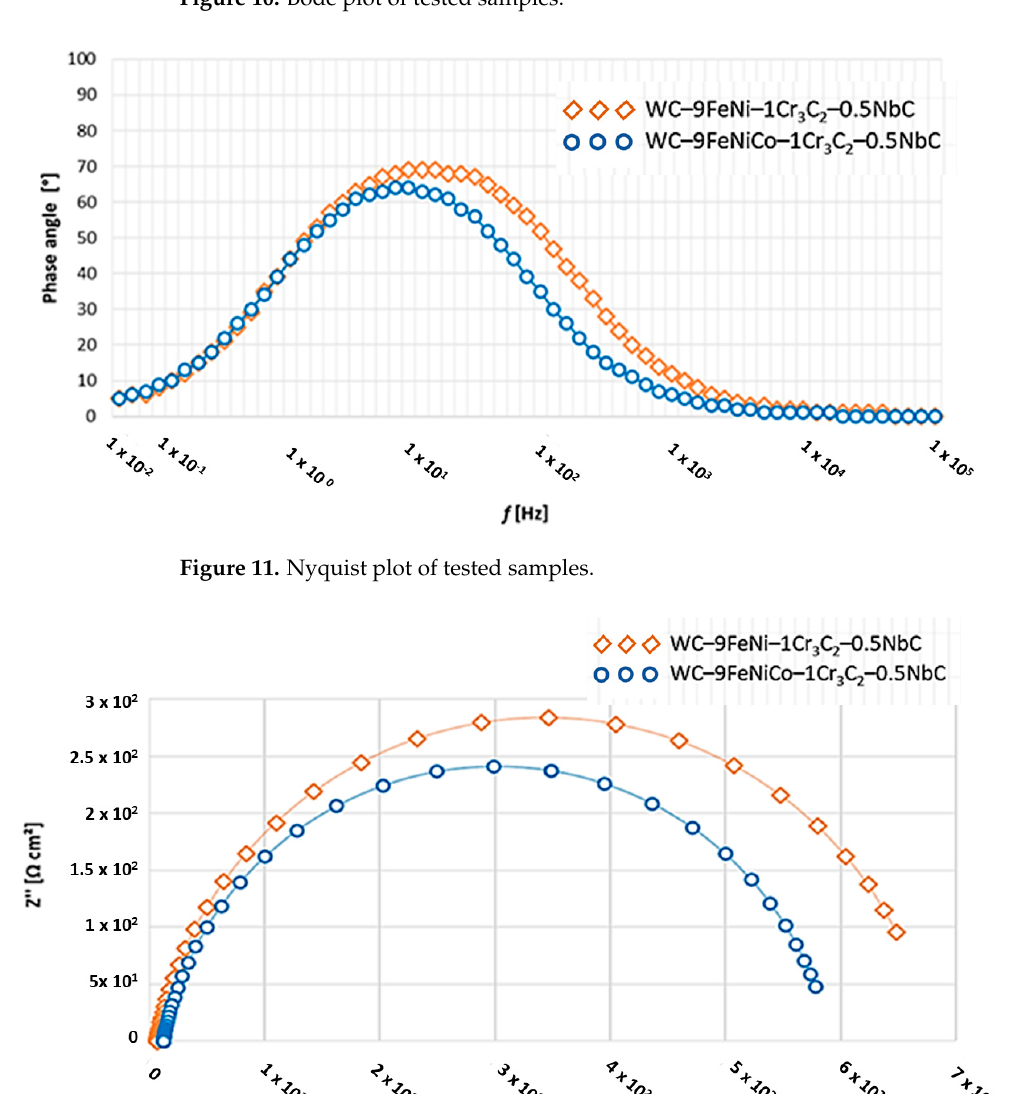
Figure 12. Phase angle as a function of the frequency of samples.